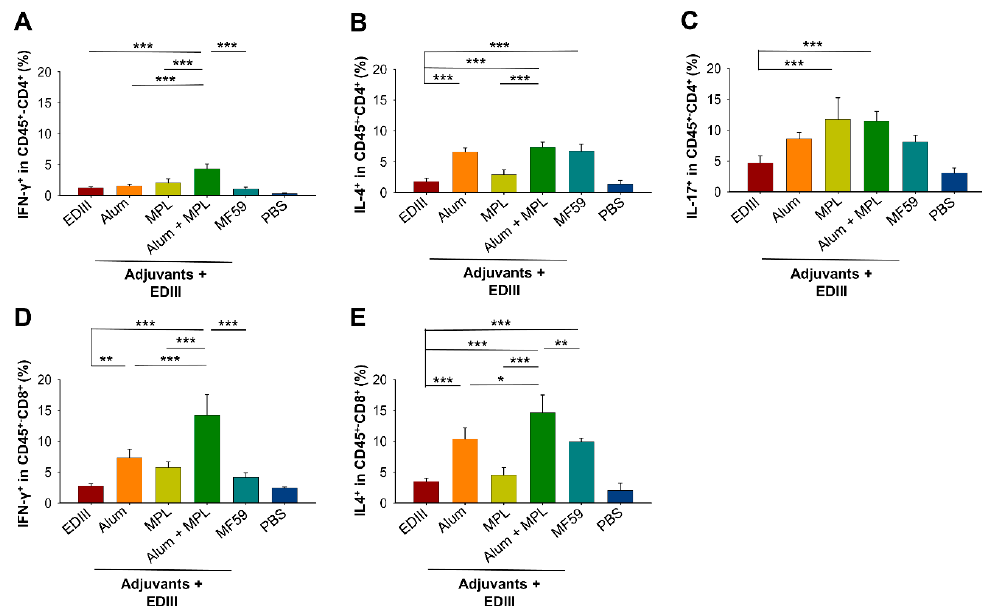
Figure 4. The e ff ect of Alum and MPL adjuvants on the ZIKV EDIII-specific cellular immune response. Splenocytes were isolated at three days post-challenge with ZIKV (strain R103451) and used to determine secretion of IFN- γ ( A ), IL-4 ( B ), and IL-17 ( C ) by CD45-positive (CD45 + )–CD4-positive (CD4 + ) T cells, and of IFN- γ ( D ) and IL-4 ( E ) by CD45 + –CD8-positive (CD8 + ) T cells using flow cytometry analysis. PBS shows the background level of cytokines. Data are expressed as the mean ± s.e.m ( n = 5). Significant differences (*: p < 0.05; **: p < 0.01; ***: p < 0.001) among different groups are shown.